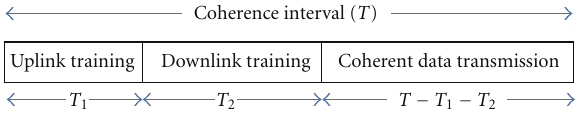
Figure 1: Transmission Phases for Oblivious